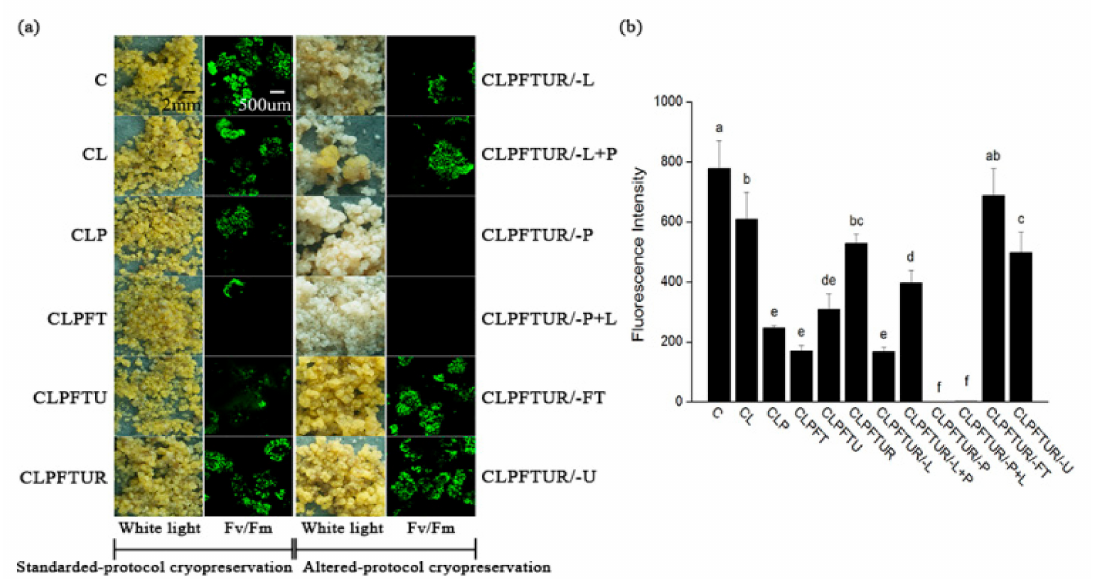
Figure 2. Viability counts of Magnolia officinalis embryogenic cells (ECs) during standard- and altered-protocol cryopreserva- tion. ( a ) Viable ECs show green fluorescence after fluorescein diacetate (FDA) staining, while dead tissues remain unstained. ( b ) Photographs are representative of three independent replicates in each case. Fluorescence intensities were recorded, and values are mean ± SD ( n = 3). Explanations of the notations used for each step are provided in full in the legend to Figure 1. Columns with different letters are significantly different ( p <